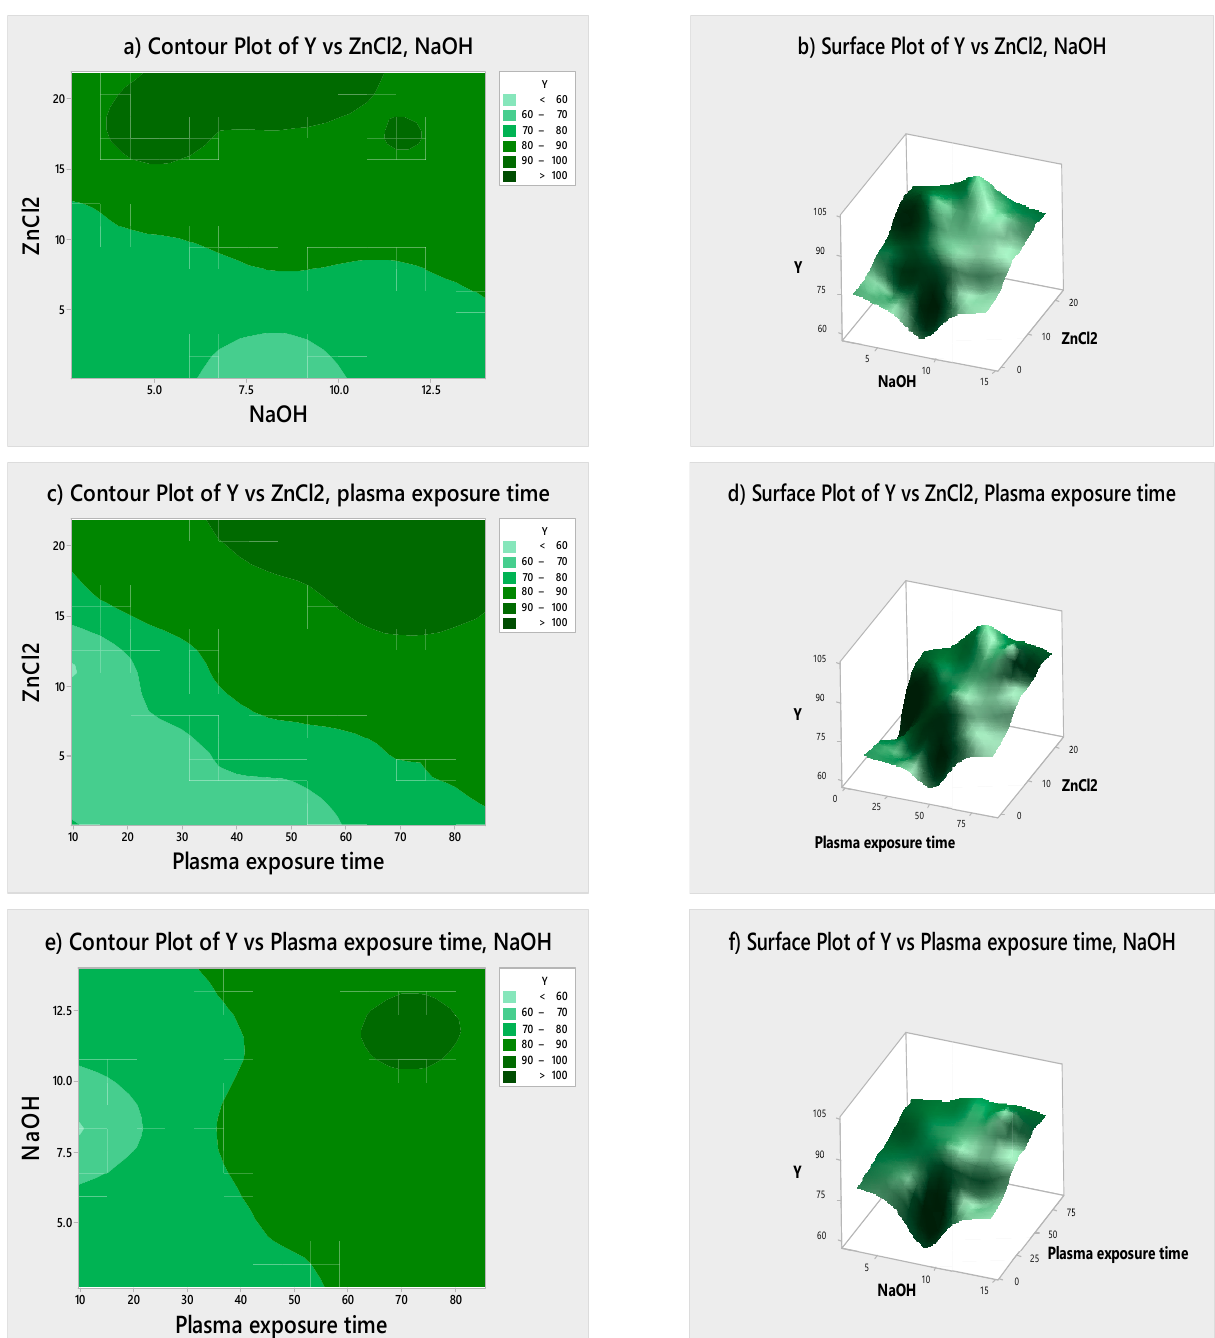
Figure 4. The surface response and contour plots of MB degradation for different experimental input parameters: ( a , b ) ZnCl 2 vs. NaOH, ( c , d ) ZnCl 2 vs. plasma exposure time and ( e , f ) NaOH vs. plasma exposure time.